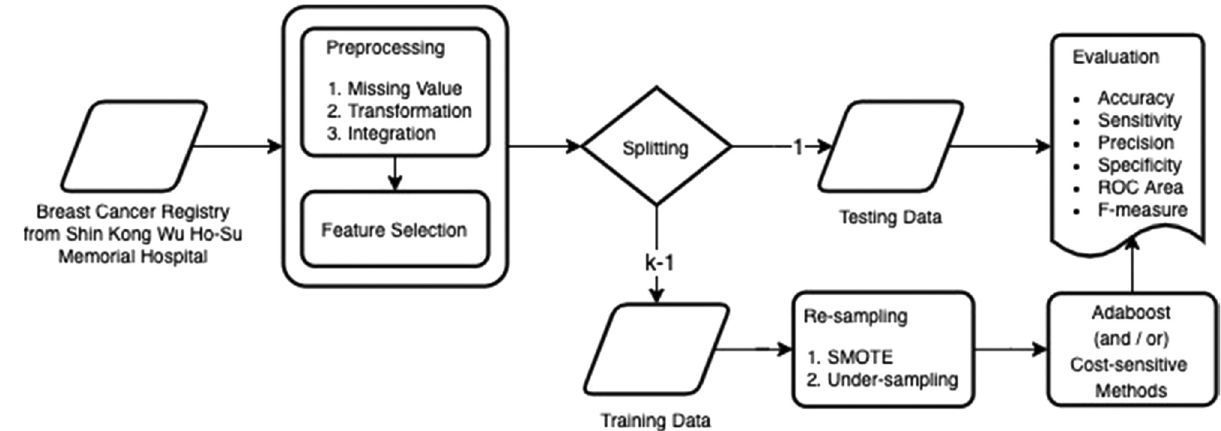
Figure 1: The approach and the process fl ow of our system